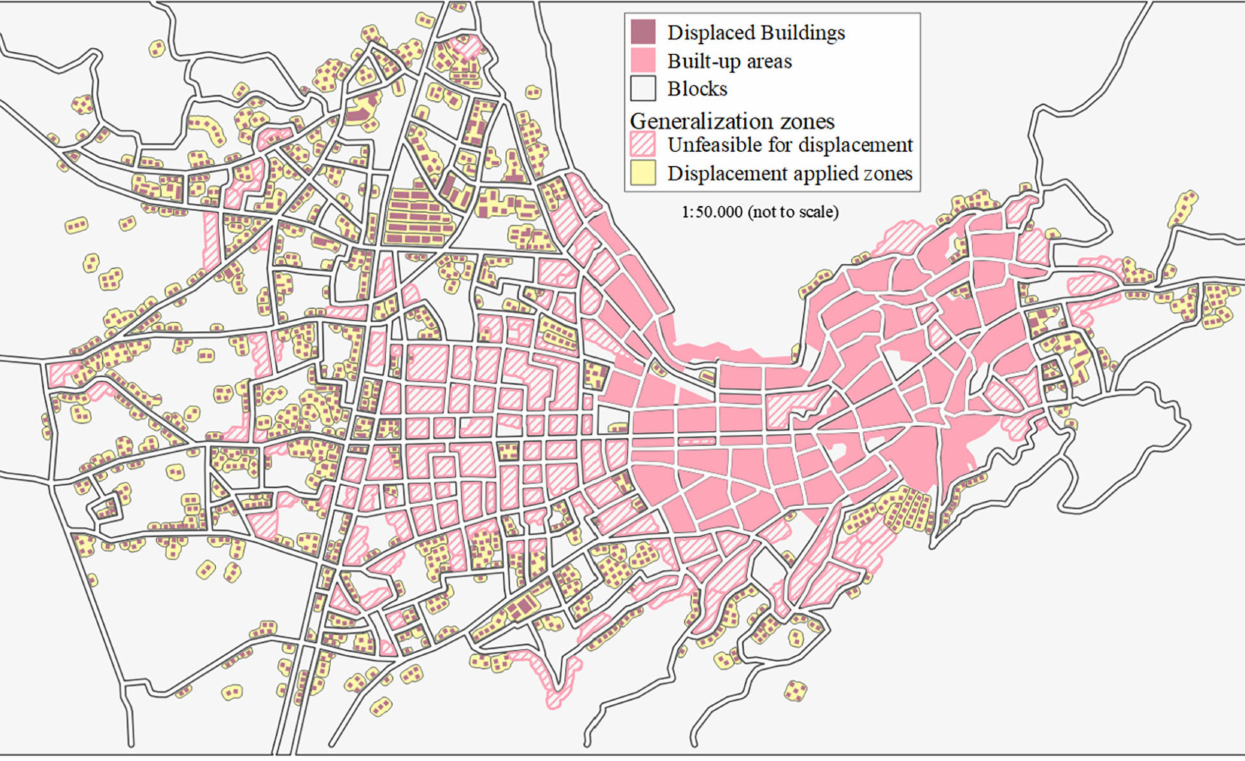
Figure A3. 1:50k topographic map data of the study area after